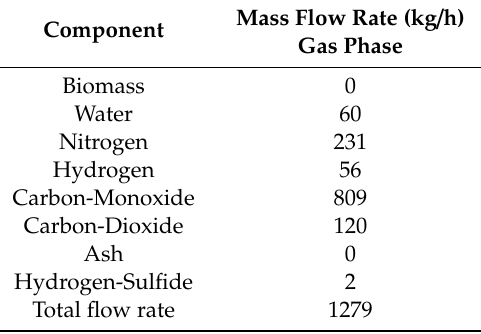
Table 3. Gasification syngas stream